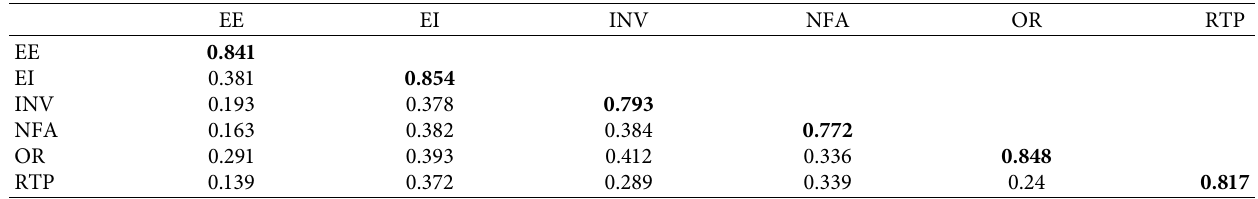
Table 3: Fornell–Larcker criterion